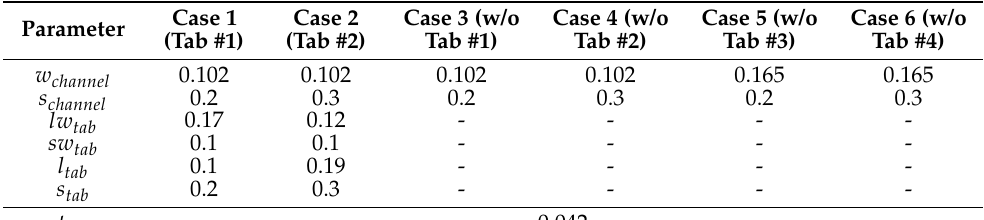
Table 2. Physical dimensions and material properties of test patterns for verification corresponding to Figure 7 (unit: mm).